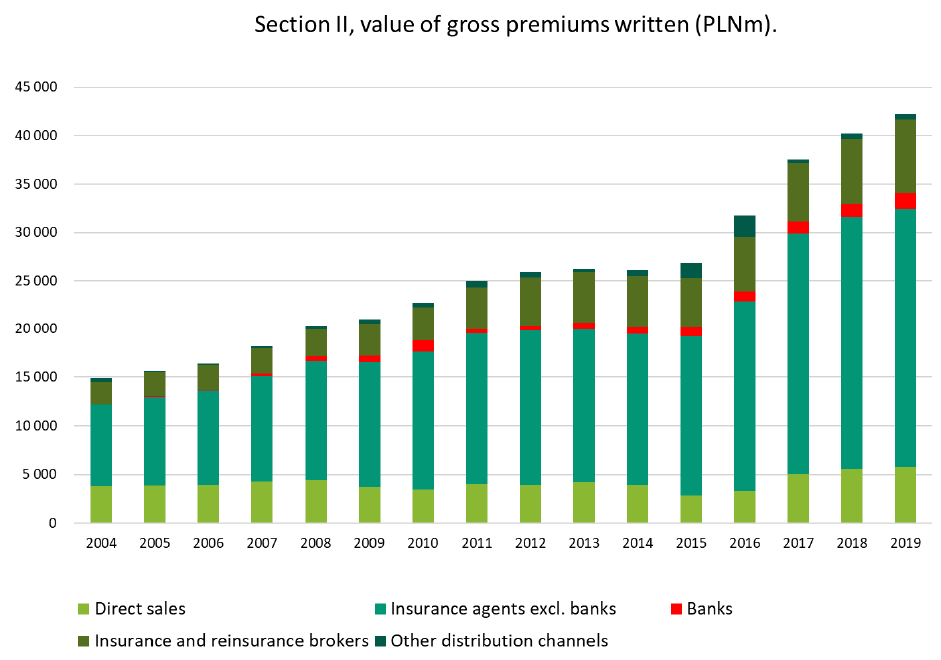
Figure 3. Value of gross premiums written in Section II, source: own study based on KNF’s data: (Polish Financial Super- vision Authority 2001–2019).